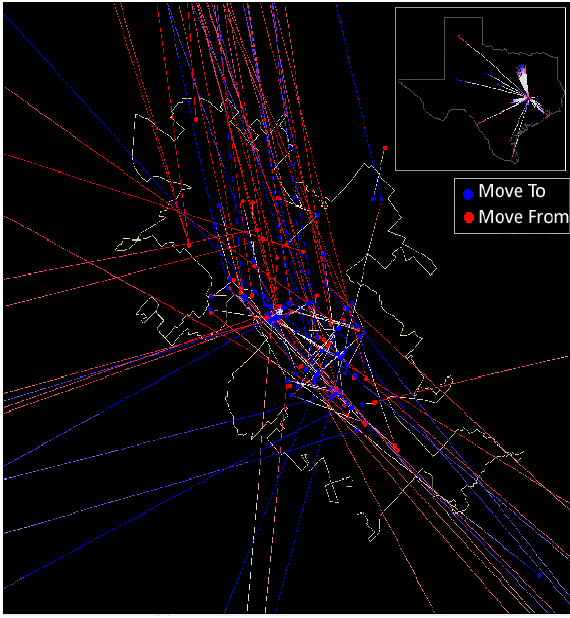
Figure 2. State-wide monochrome vector map of migration